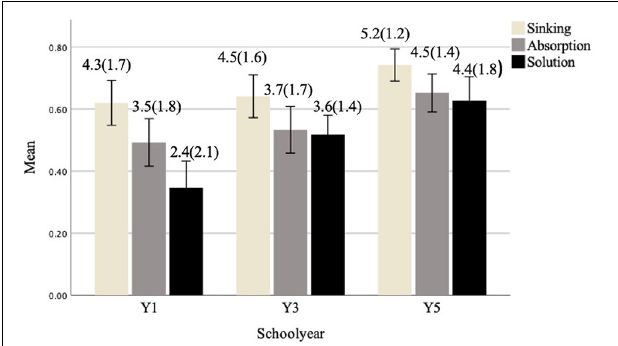
FIGURE 1 | Response profile means for each causal measure by year groups, with standard deviations in